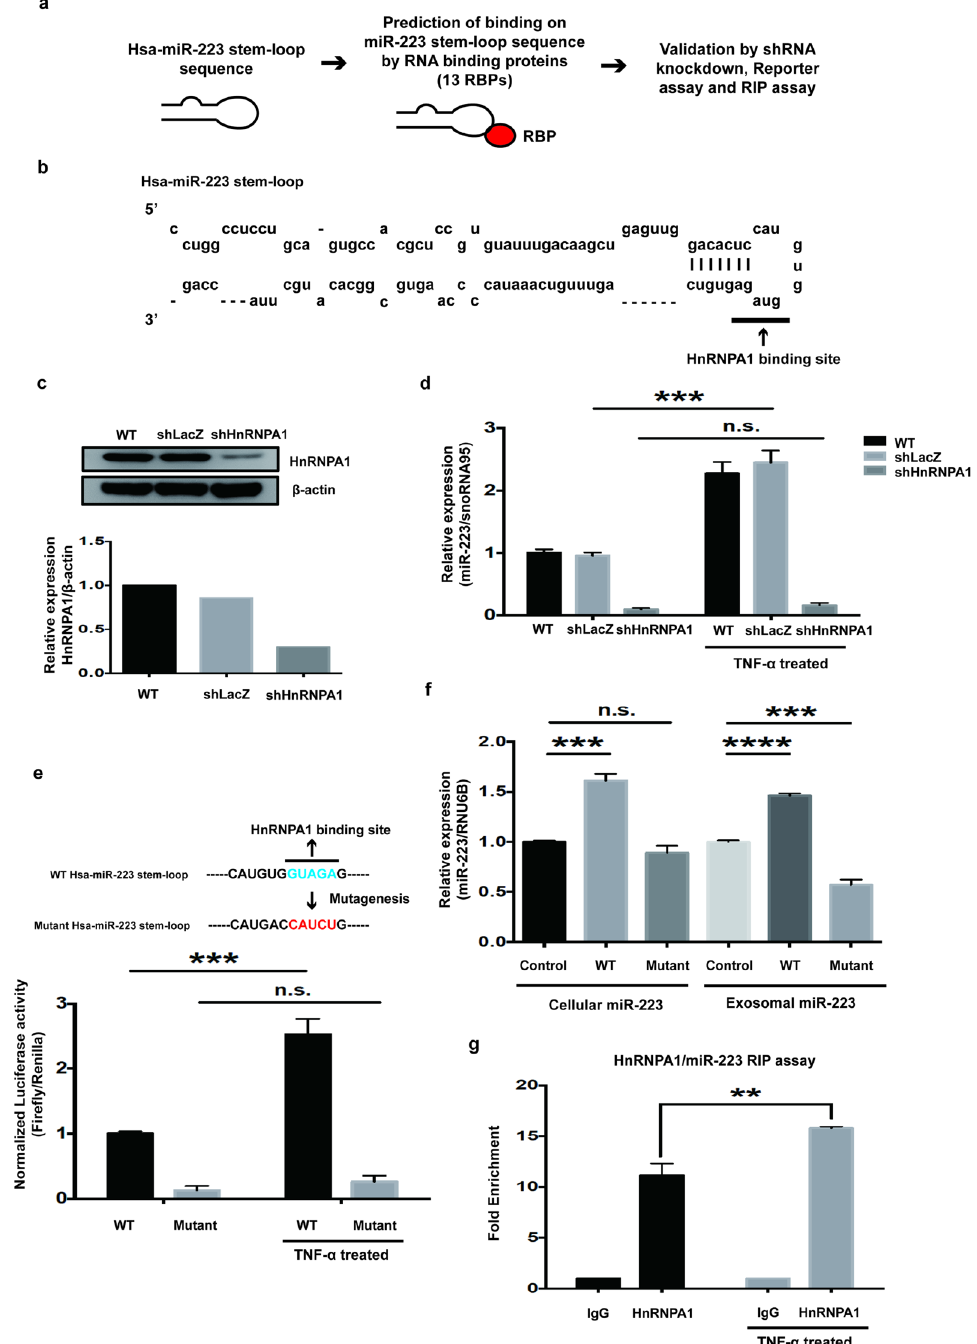
Figure 7. hnRNPA1 affects exo-miR-223-3p levels. ( a ) Schematic representation for identification of RBP mediated miR-223 recognition ( b ) hnRNPA1 motif (GUAGUAGU) binds to stem-loop structure of pre- miR-223 as determined by RBP map computational tool. ( c ) K562 cells were transfected with shRNAs against hnRNPA1 or control LacZ. Densitometric analysis of western blots shows successful shhnRNPA1 knockdown (KD). ( d ) miRNA RT-qPCR analysis of exo-miR-223-3p levels in K562- shhnRNPA1-KD or shLacZ cells in the presence/absence of TNF- α treatment for 24 hrs. ( e ) Schematic representation of viral pLAS2 vector and wild-type (WT) or mutant (MT) hnRNPA1 binding site in stem-loop miR-223 sequence. Reporter assay in K562 cells transfected with miR-223-WT or -MT and with/without TNF- α treatment for 24 hrs. ( f ) Cellular and exo-miRNA-223-3p levels in TNF- α induced K562 cells in the presence of wild-type (WT) or mutant (MT) stem loop miR-223-3p vector. ( g ) RNA immunoprecipitation assay for miR-223-3p was performed with anti-hnRNPA1 or IgG as a control antibody in K562 cells treated with or without TNF- α . Experiments were performed in triplicates. The values represented are mean ± SD, two-way ANOVA, ** P < 0.01, *** P < 0.001, **** P < 0.0001, Prism6 (GraphPad Software